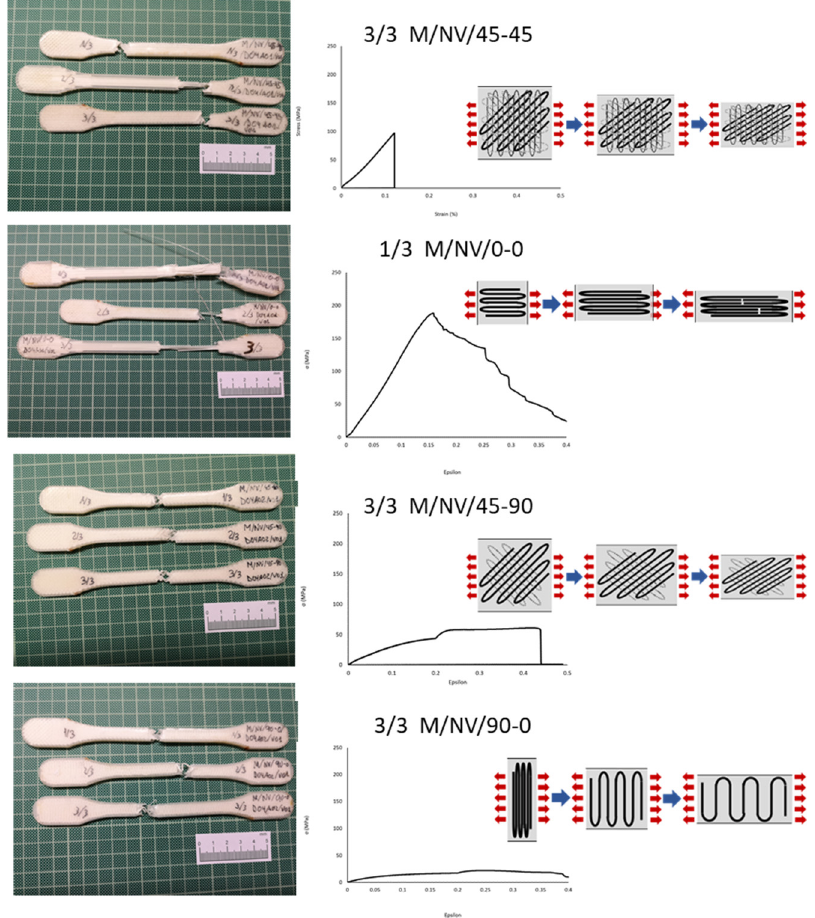
Figure 20. Nylon + Glass Fiber MNV45-45, MNV0-0, MNV45-90, and MNV90-0 specimens; Stress- Strain graphs; and fiber behavior for each deposition pattern.